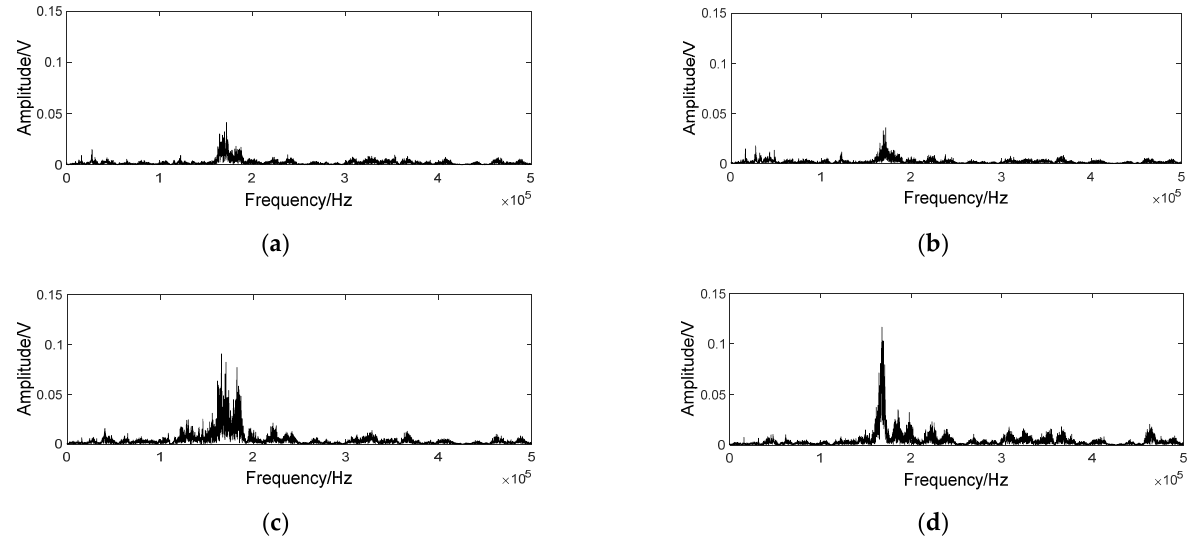
Figure 8. The output of different nodes through the same kernel. ( a ) the 3rd node; ( b ) the 5th node; ( c ) the 13th node; ( d ) the 17th node.